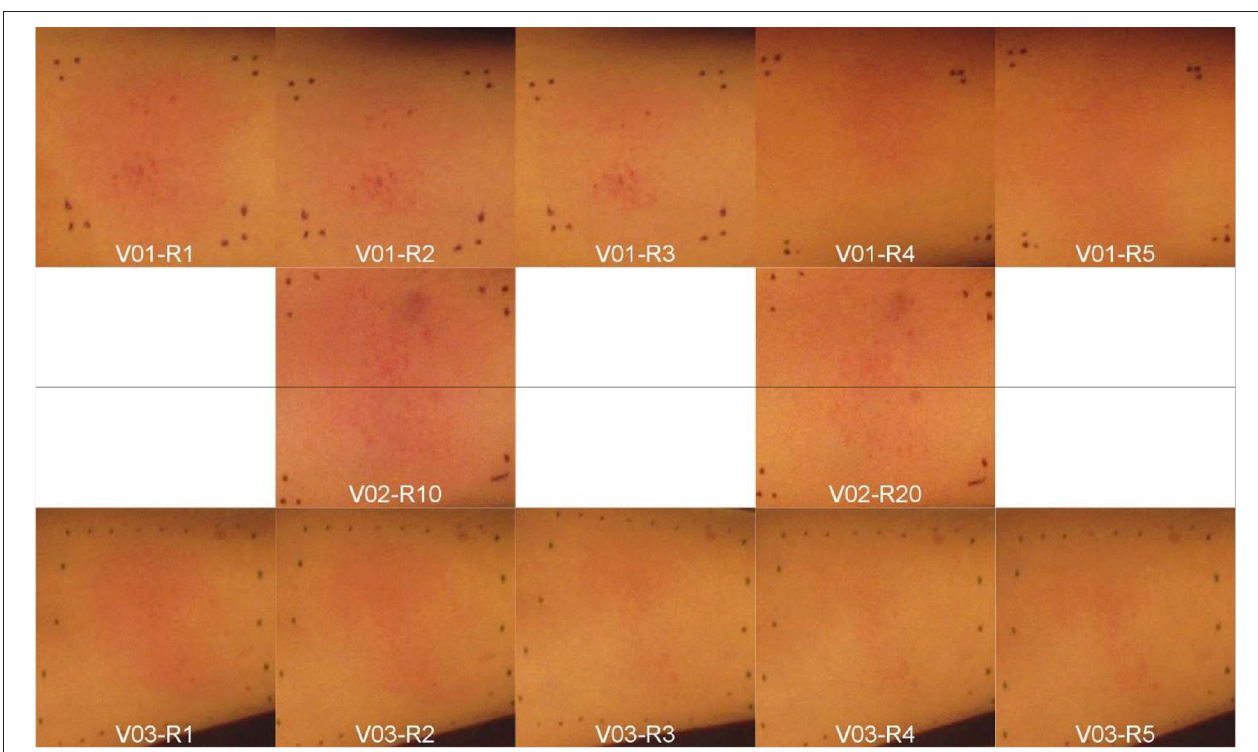
FIGURE 3 | Artificially induced skin erythema on three volunteers’ (V01-V03) forearms. Each row represents a different subject (V01-V03). All the images were captured sequentially by the digital color camera at 3-minute intervals or rounds (R1-R20) after inducing erythema. The V02’s images were named as R10 and R20 just for arrangement purpose within the